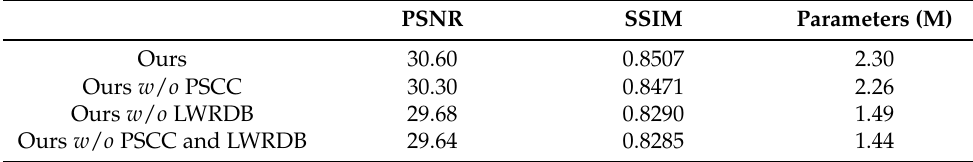
Table 5. Ablation studies for each module in the proposed LWRDB